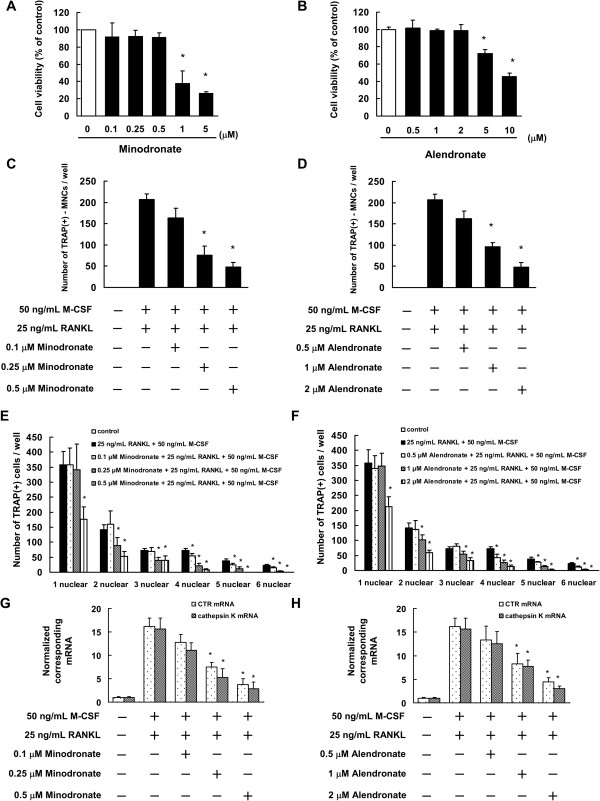
Minodronate and alendronate inhibited osteoclast formation in C7 cells. (A, B) Determination of the appropriate concentrations of minodronate (A) and alendronate (B) that are not cytotoxic to C7 cells. Cells (5000 cells/well) were incubated in 96-well plates for 24 h and then treated with various concentrations of minodronate and alendronate. After 12 days, cell viability was quantified by conducting WST-8 assays. The results are representative of 5 independent experiments. *P < 0.01 compared to the controls. (C-F) Inhibition of osteoclast formation by minodronate and alendronate. C7 cells were cultured for 12 days and then treated with 0.1, 0.25, or 0.5 μM minodronate (C, E) or 0.5, 1, or 2 μM alendronate (D, F). Cells were cultured in the presence of 25 ng/mL RANKL plus 50 ng/mL M-CSF. Cultures were fed every 3 days by replacing with 500 μL of fresh medium with or without minodronate, alendronate, RANKL, and M-CSF. Cultures were fixed and stained for TRAP-positive multinucleated cells (C, D), and TRAP-positive cells (E, F) per well was counted. These results are representative of 5 independent experiments. *P < 0.01 compared to 25 ng/mL RANKL plus 50 ng/mL M-CSF administration. (G, H) Inhibitory effect of minodronate and alendronate on RANKL and M-CSF-induced CTR and cathepsin K mRNA expression. C7 cells were treated with minodronate (G) or alendronate (H) with 25 ng/mL RANKL plus 50 ng/mL M-CSF for 12 days. Total RNA was extracted and the levels of CTR and cathepsin K mRNA expression were determined by real-time PCR. The results are expressed as the ratio of treated to control samples after normalization to GAPDH mRNA levels. The results are representative of 4 independent experiments. *P < 0.01 compared to 25 ng/mL RANKL plus 50 ng/mL M-CSF administration.